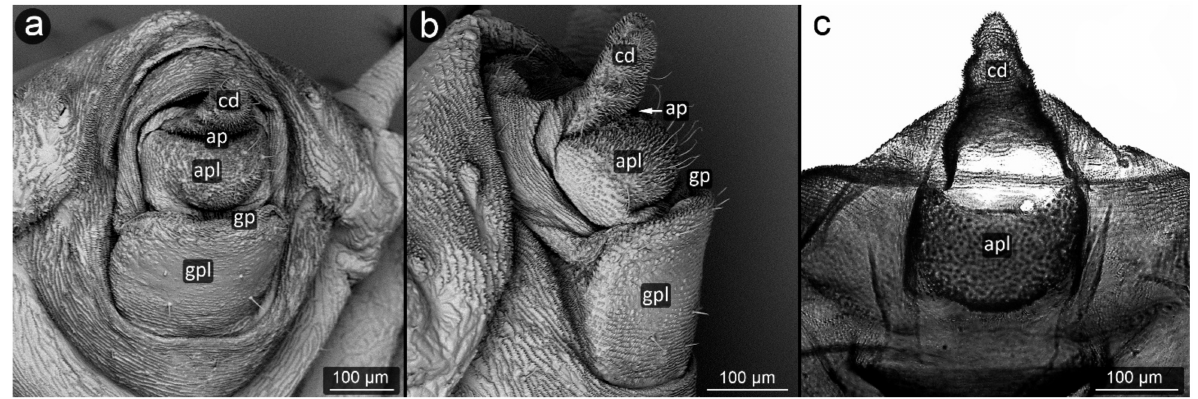
Figure 28. Perianal structure of Myzus cerasi ; ( a )—rear view (SEM), ( b )—lateral view (SEM), ( c )— rear view in light microscopy.